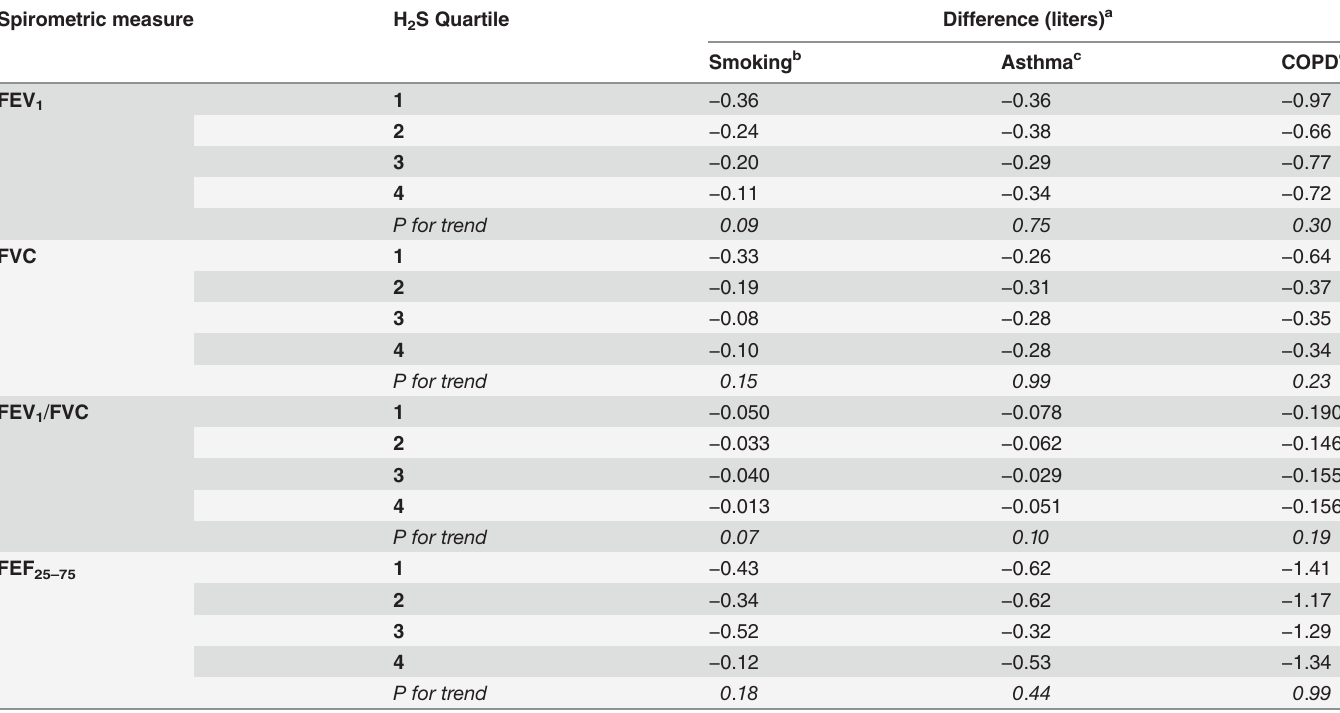
Table 4. Adjusted differences between ever- and never-smokers, people with and without asthma, and people with and without COPD, by quartile of long-term (30 year) time-weighted average H 2 S exposure. Spirometric measure